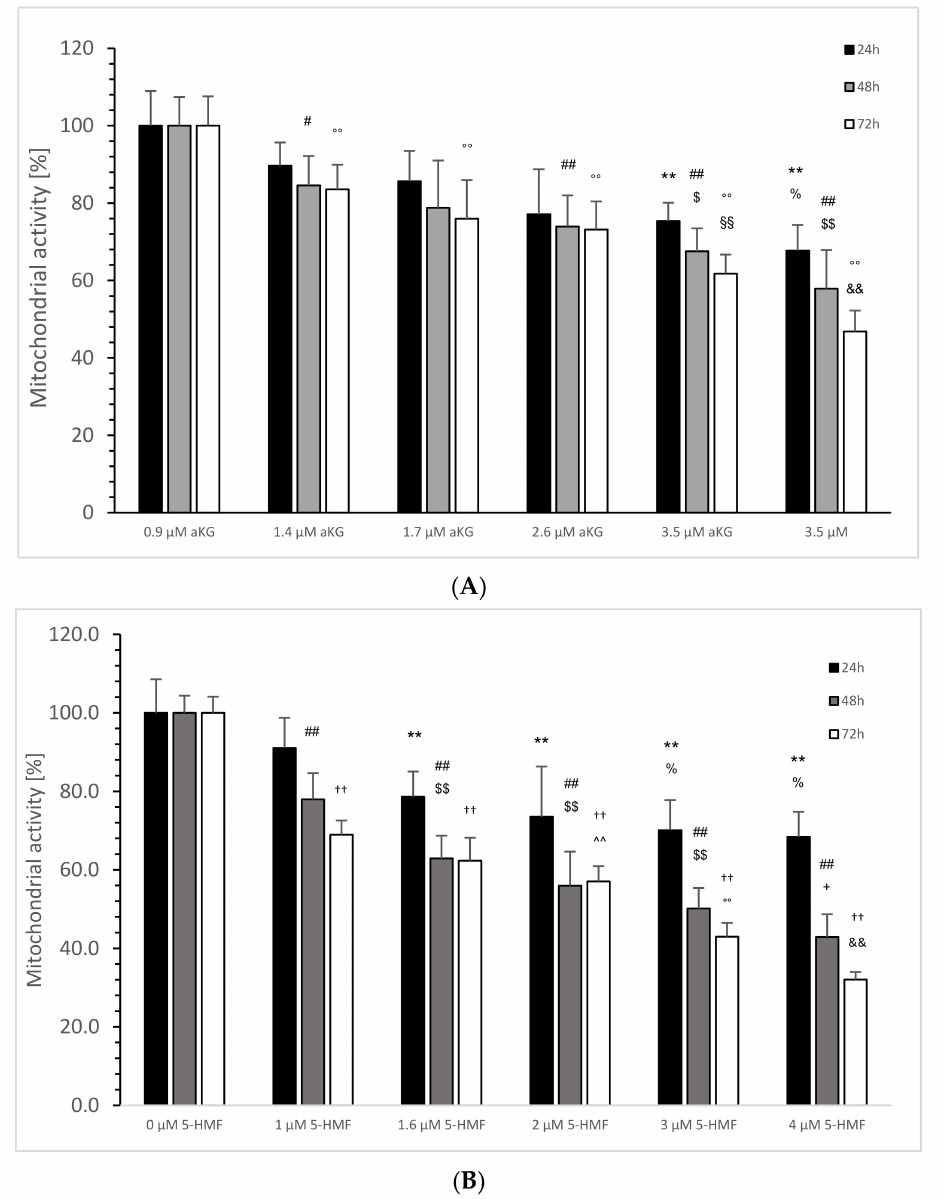
Figure 5. Calculated mitochondrial activity in percentage of the Jurkat cell line in the absence or presence of 0, 0.9, 1.4, 1.7, 2.6 and 3.5 µ M aKG ( A ) or 0, 1, 1.6, 2, 3 and 4 µ M 5-HMF ( B ) after 24, 48 and 72 h of cultivation ( n = 5). ( A ) On 24 h incubation: ** p < 0.01: significance between 0 µ M aKG